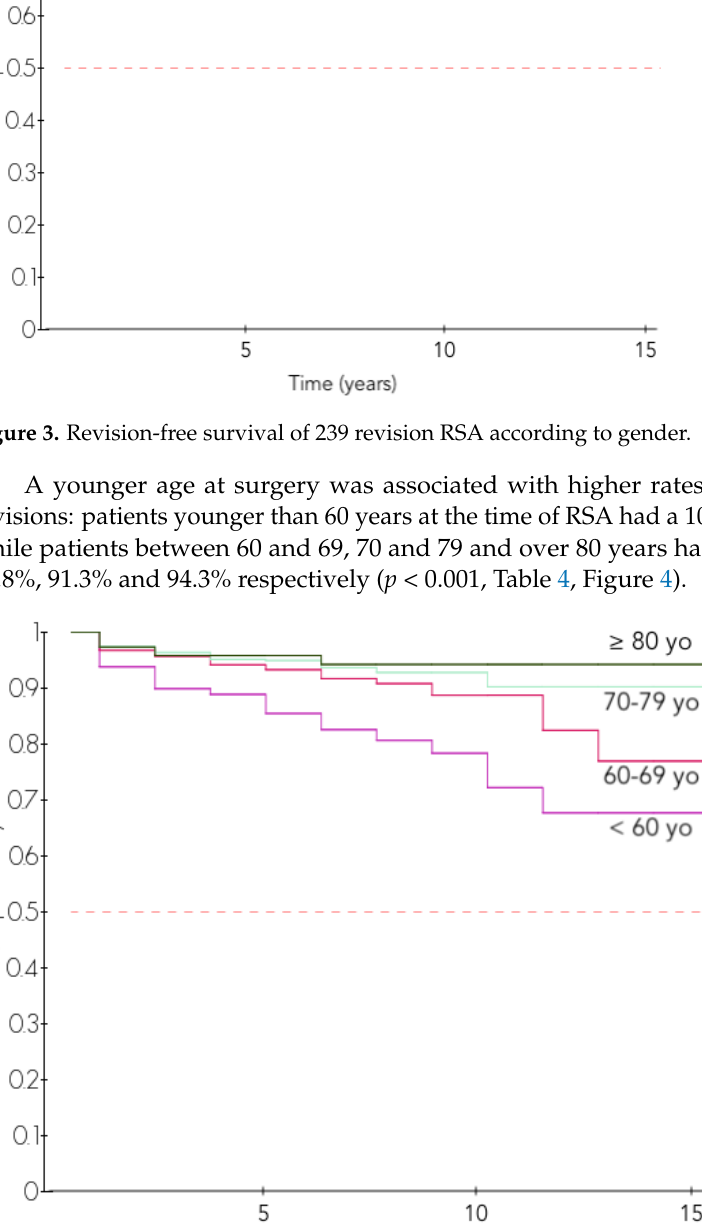
Figure 4. Revision-free survival according to the age at surgery. This association was maintained after stratification over gender with males and fe- males requiring more revision surgeries when operated younger (Table 5). In the 70–79 age group, the males had more revisions than the females (8.5% vs. 4.5%; p = 0.034) but the difference was not significant for other age groups. Revision RSA performed in male younger than 60 years led to a 10-year survival rate of 72.3%. Table 5. Revision rate according to age stratified by gender. Revision Rate (%)